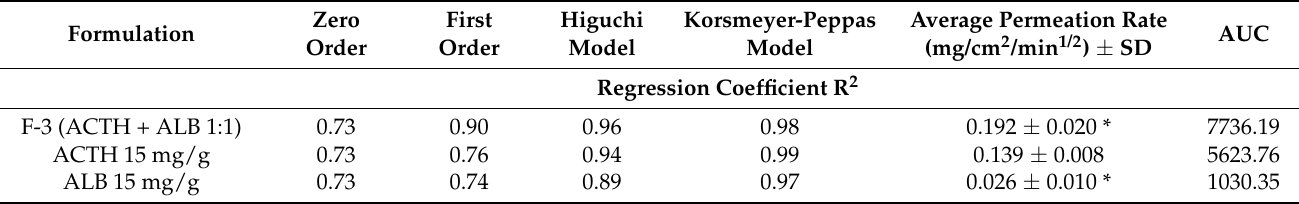
F-3 (ACTH + ALB 1:1) ACTH 15 mg/g ALB 15